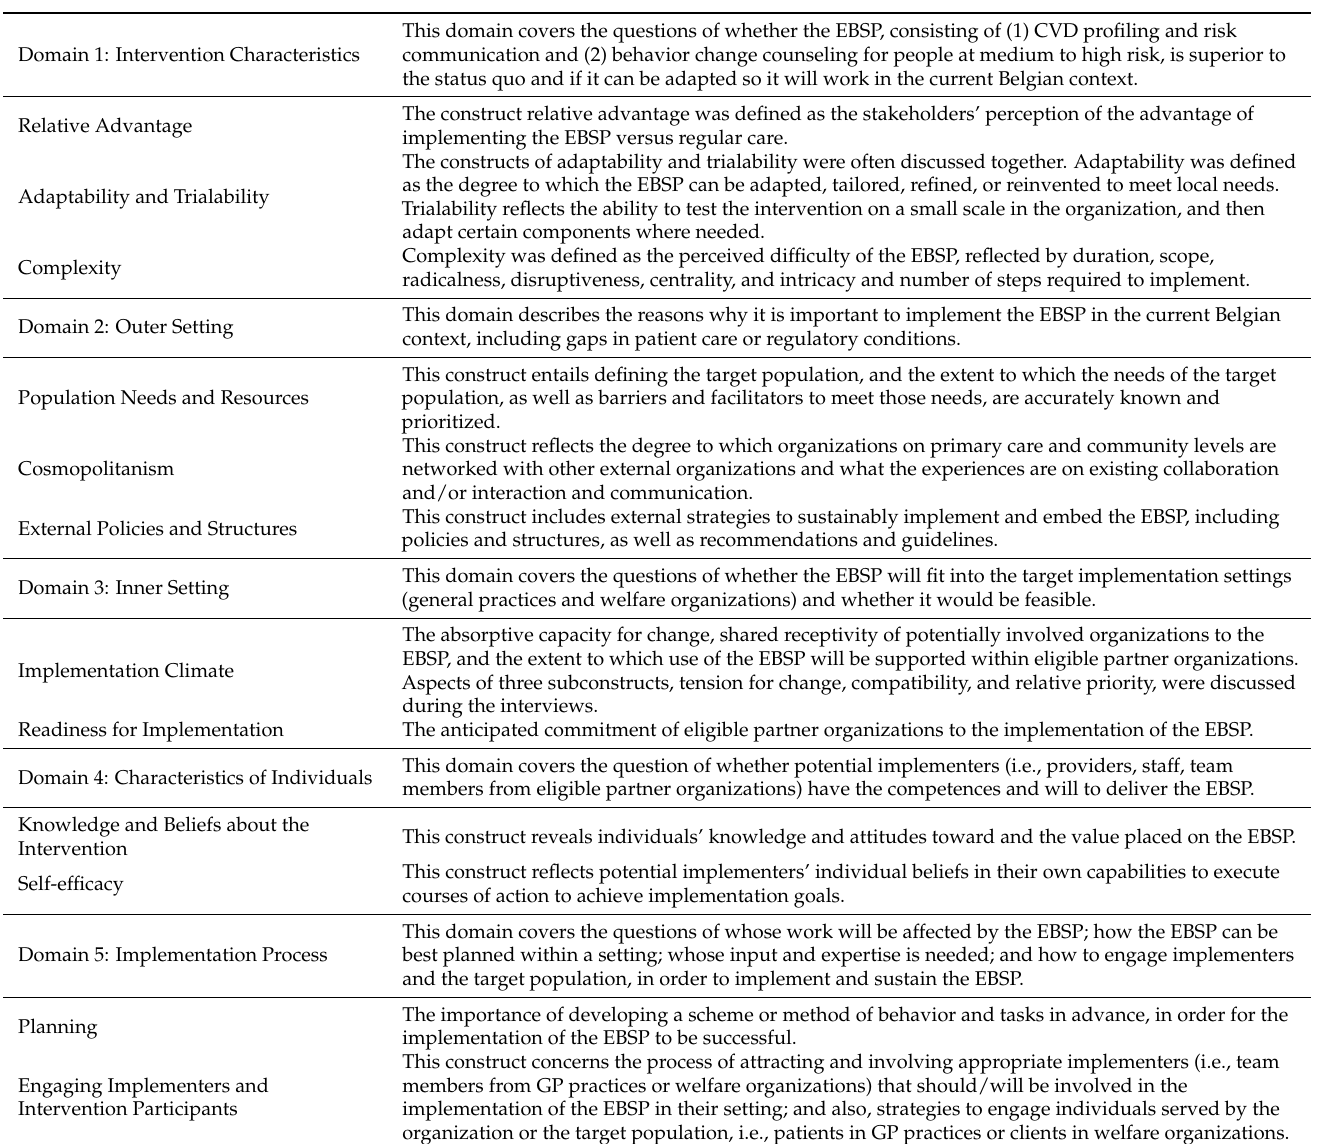
Table A1. Operational definitions of relevant CFIR domains and